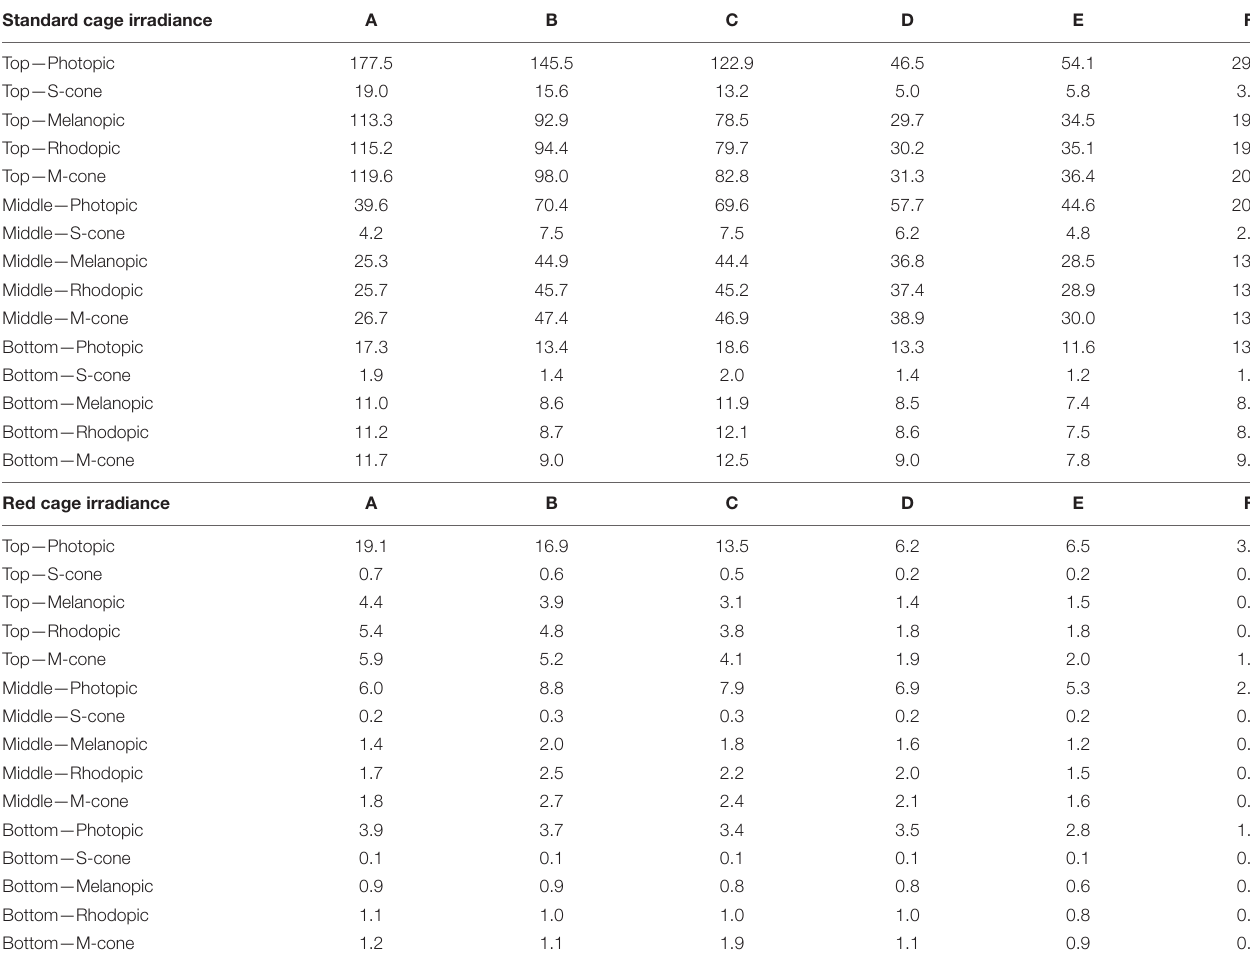
TABLE 1 | Light intensity in photopic lux and other α -opic irradiance, in each column (A–F) of the DVC rack across the top, middle, and bottom rows. Standard cage